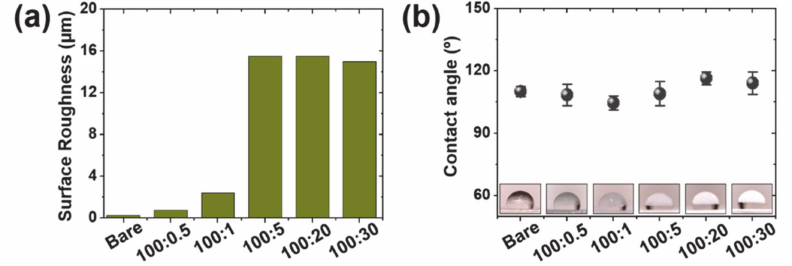
Figure 3. ( a ) Surface roughness and ( b ) contact angles with respect to PDMS:GB mixing ratio (PDMS base 100: GB X). Inset images: Microscopic camera images of water drops on surfaces of